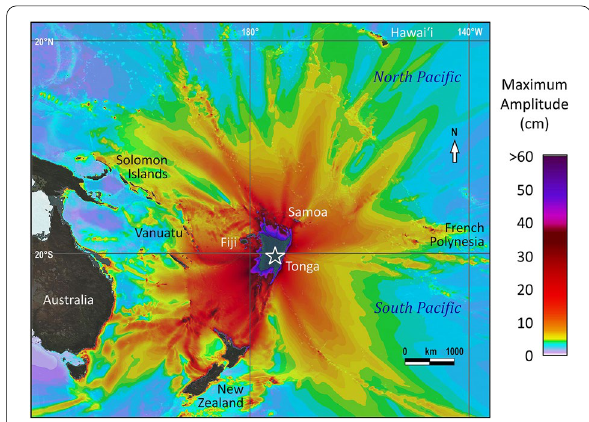
Fig. 4 Modelled maximum tsunami amplitude following the eruption of HTHH volcano on 15 January 2022. The location of the volcano in Tonga is indicated by the white star. The propagation does not include any tsunami component induced by atmospheric shockwaves. Base image courtesy of the NOAA Center for Tsunami Research (NOAA 2022)